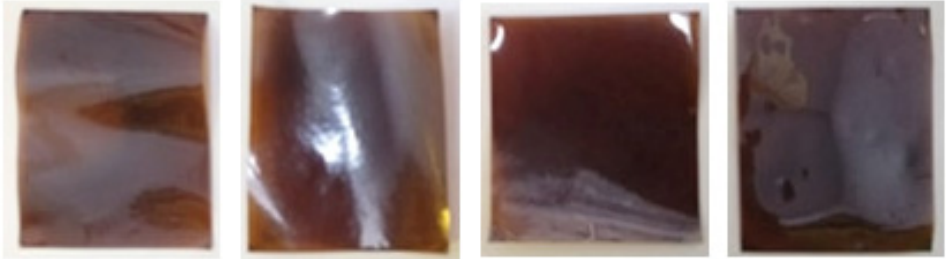
Figure 1. Photo of SPPQ films with sulfur content 2.6, 4.2, 5.5, and 7%. Elemental analysis . Determination of the sulfur content in polymer electrolytes was carried out on a universal elemental CNS analyzer Vario Micro Cube (Langenselbold, Germany). According to the elemental analysis data, the sulfur content in the SPPQ samples is 2.6, 4.2, 5.5, and